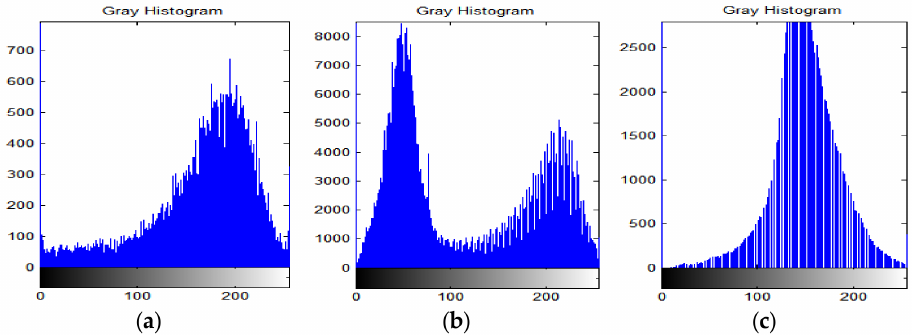
Figure 5. Gray histogram. ( a ) Macroscale image; ( b ) Mesoscale image; ( c ) Microscale